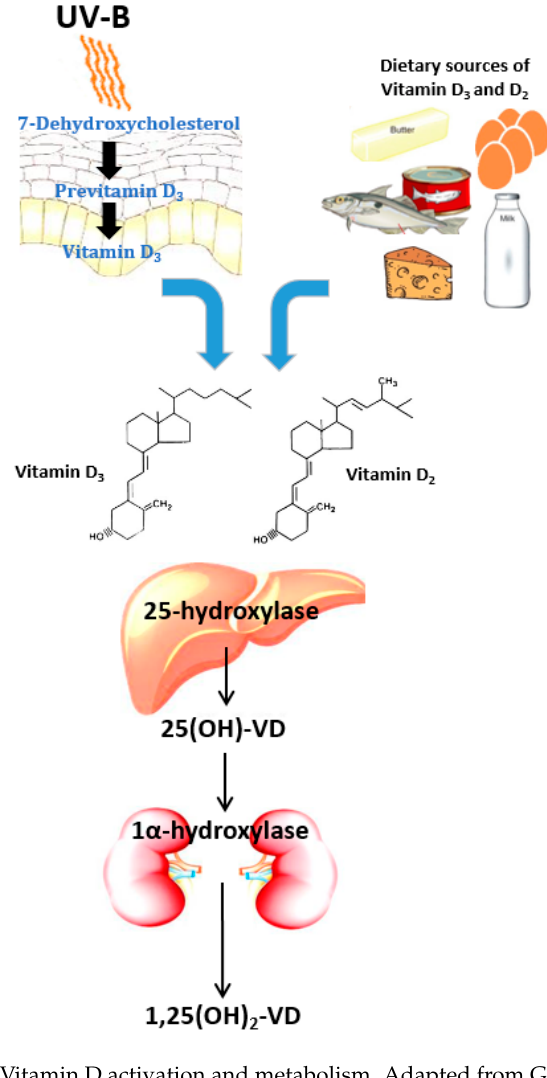
Figure 1. Vitamin D activation and metabolism. Adapted from Gois et al [3].